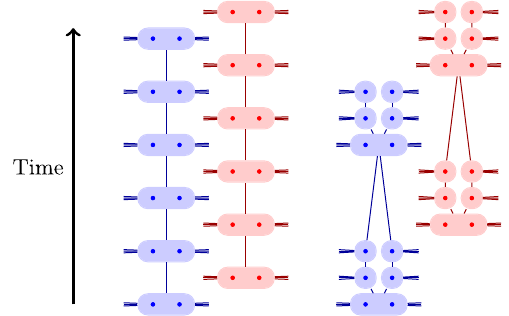
FIG. 9. Matching graph for a single face of the subsystem toric code using a homogeneous ð ZX Þ 6 schedule (left) and a homo- geneous ð Z 3 X 3 Þ 2 schedule (right). The vertical axis corresponds to time, with the direction of time being from bottom to top. Small blue- and red-filled circles correspond to Z and X gauge operator measurements, respectively, with each vertical column of small filled circles corresponding to a single gauge operator. Large light-blue- and light-red-filled rounded rectangles (or rounded squares) correspond to stabilizers being the product of the gauge operators they enclose. Diagonal edges (between stabilizers that differ in space and time) are omitted for clarity. Blue and red lines correspond to edges in the Z and X matching graphs,